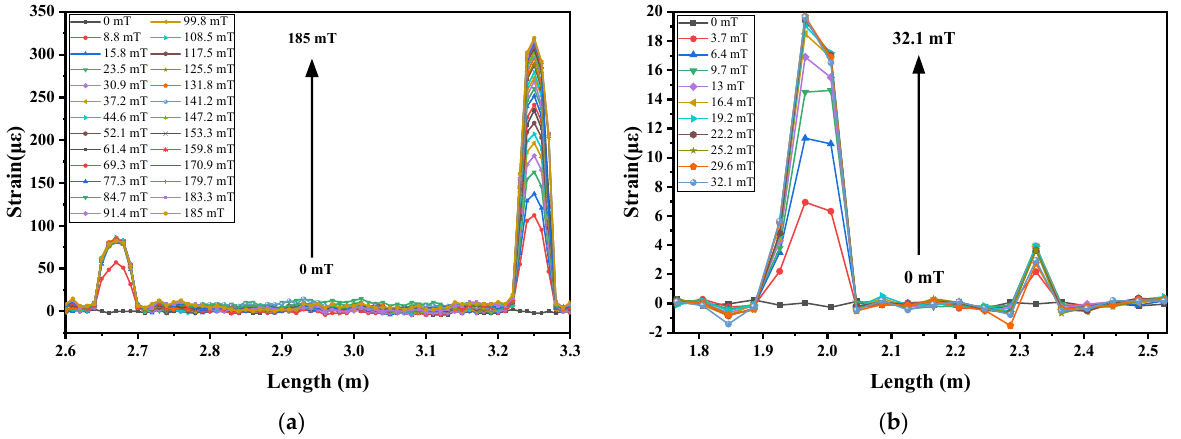
Figure 5. Strain response traces induced by magnetic field for ( a ) the sensor of #1-Fe-Ga and #2-Tb- Dy-Fe at 2.67 m and 3.25 m, respectively; ( b ) the sensor of #4-Fe-Ga-SMF and #5-Fe-Ga-Bare-SMF at 2.32 m and 1.97 m, respectively.